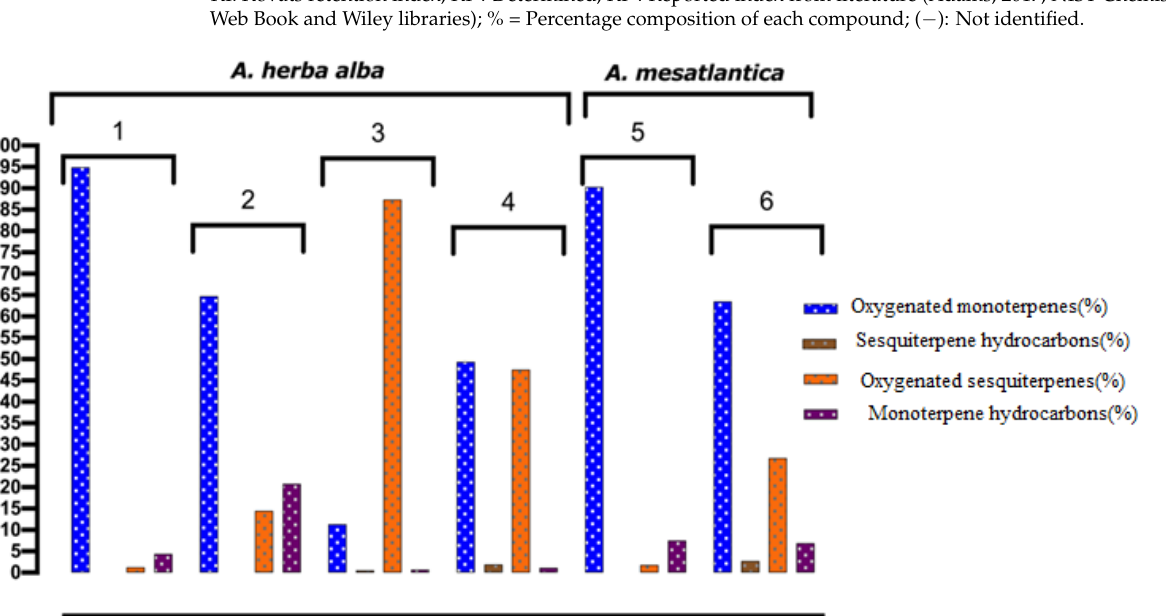
Table 4. Overall percentages (%) of the different chemical families identified in the EO of A. herba alba Asso: Oulad aliyoussef, Serghina, Enjil and Timahdit; A. mesatlantica Maire: Guigou and Timahdit. Components